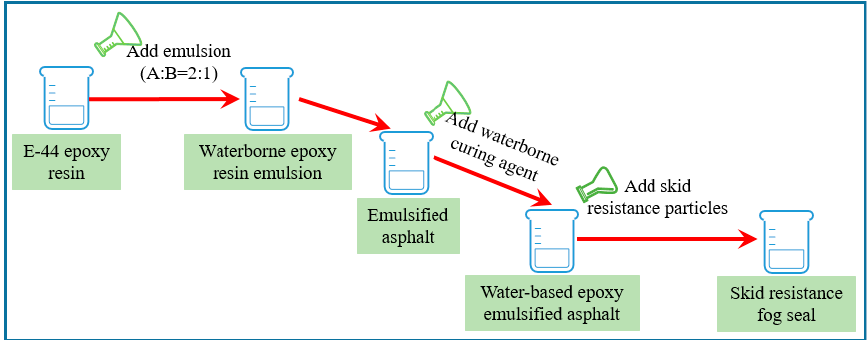
Figure 10. Preparation process of skid resistance fog seal.